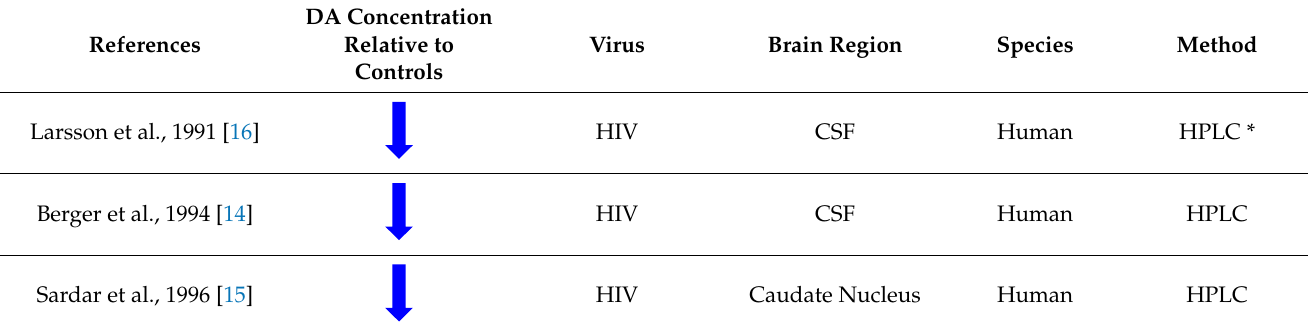
Table 2. Influence of HIV-1 viral protein exposure on dopamine (DA) concentration relative to con- trols. Asterisks (*) indicate manuscripts that measured DA metabolites (e.g., homovanillic acid). Symbols: DA concentration is decreased ( ) or increased ( ) relative to controls. The equal sign ( ) indicates no statistically significant differences in DA concentration between HIV and con- trols.